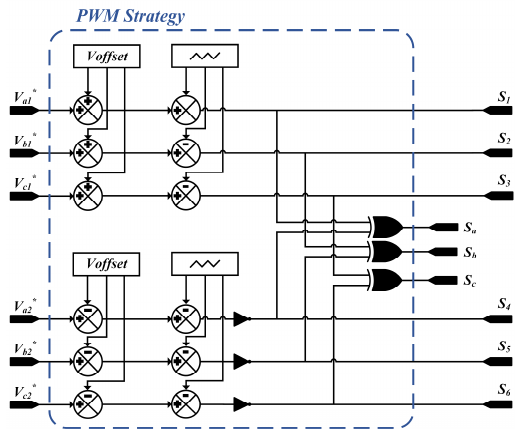
Figure 19. PWM control strategy for nine-switch converters.